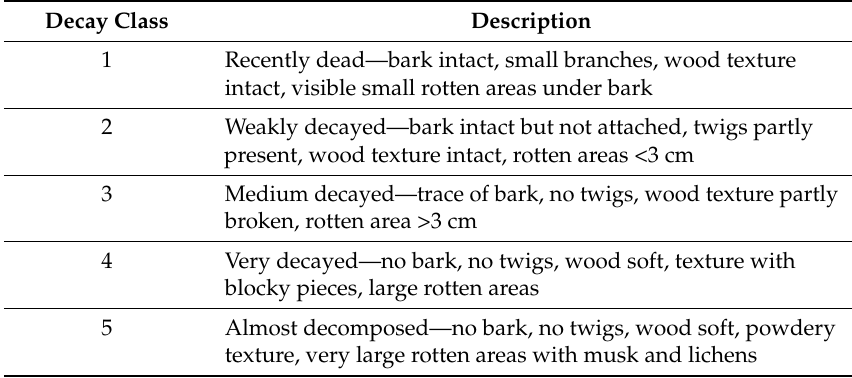
Table 1. Description of visual characteristics used to assign decay class of deadwood in a black